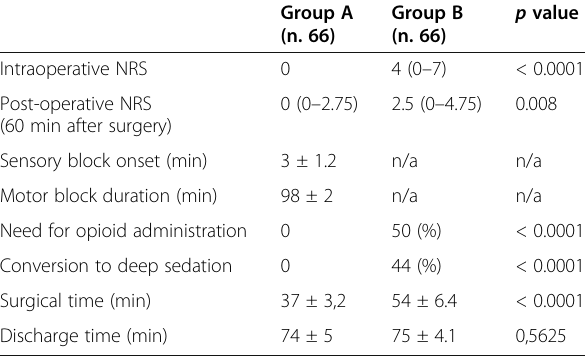
Table 2 Post-randomization